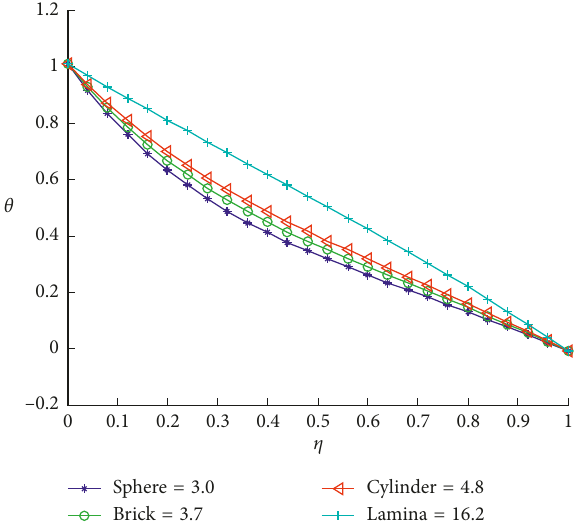
0 . 5 , Le (cid:31) (cid:31) Figure 14: Effect of the nanoparticle shape factor on the tem- Nb perature profile when A 2 ,S 1 , Nt 0 . 2 , β 0 . 05 , M (cid:31) (cid:31) (cid:31) (cid:31) (cid:31) Pr 0 . 5 , Le 3 . 0 , c 0 . 1 , and C (cid:31) (cid:31) (cid:31)